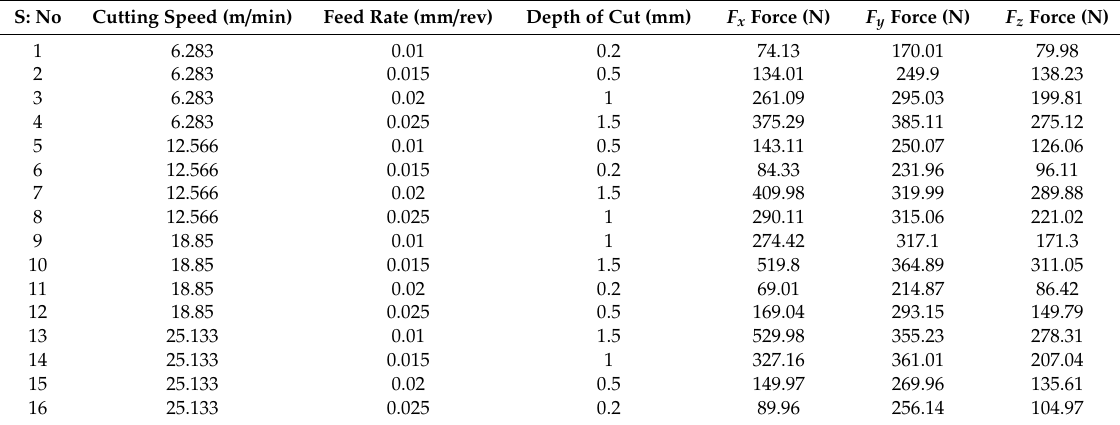
Table 2. The machining parameters and experimental data of cutting force, F x , F y , F z obtained in turning process of SiCp / Al